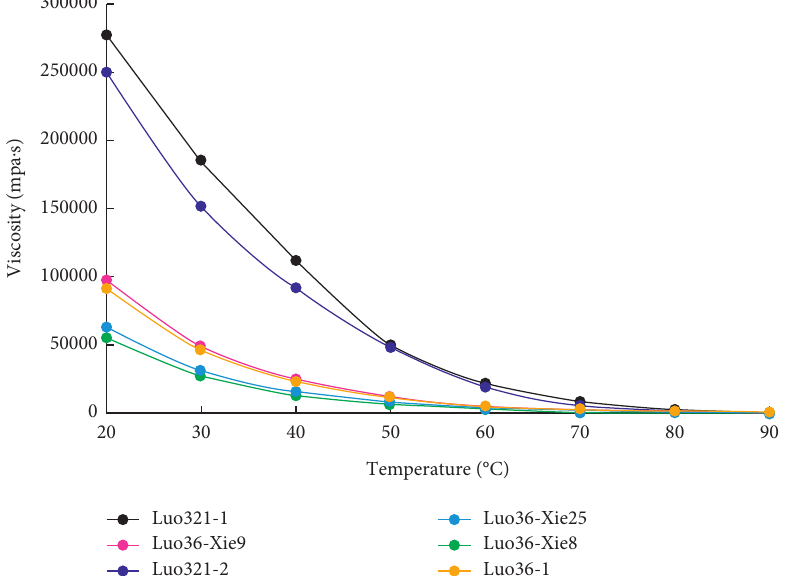
Figure 2: Viscosity-temperature curve of each oil sample.